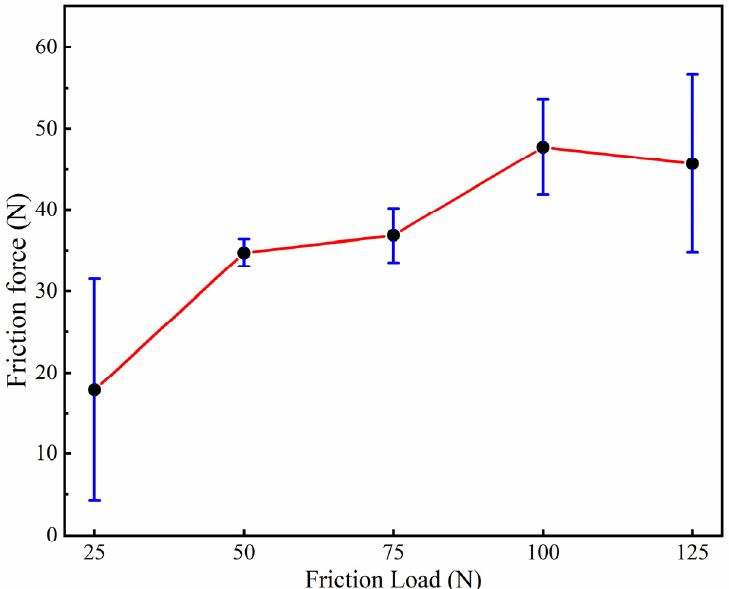
Figure 14. The curve of the mean frictional force and frictional load of sample YG8-30 (the points represent the frictional forces of the sample YG8-30 under different loads; the error value of the frictional force is shown in green; red indicates the shift curve between the load and frictional forces).